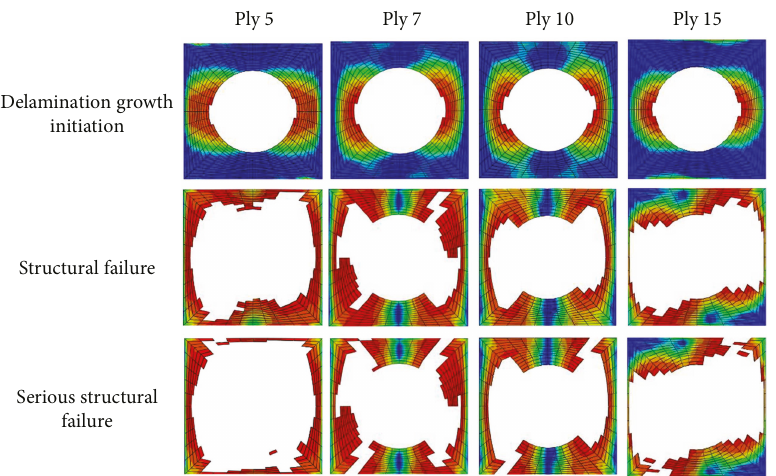
Figure 17: Delamination evolution with F